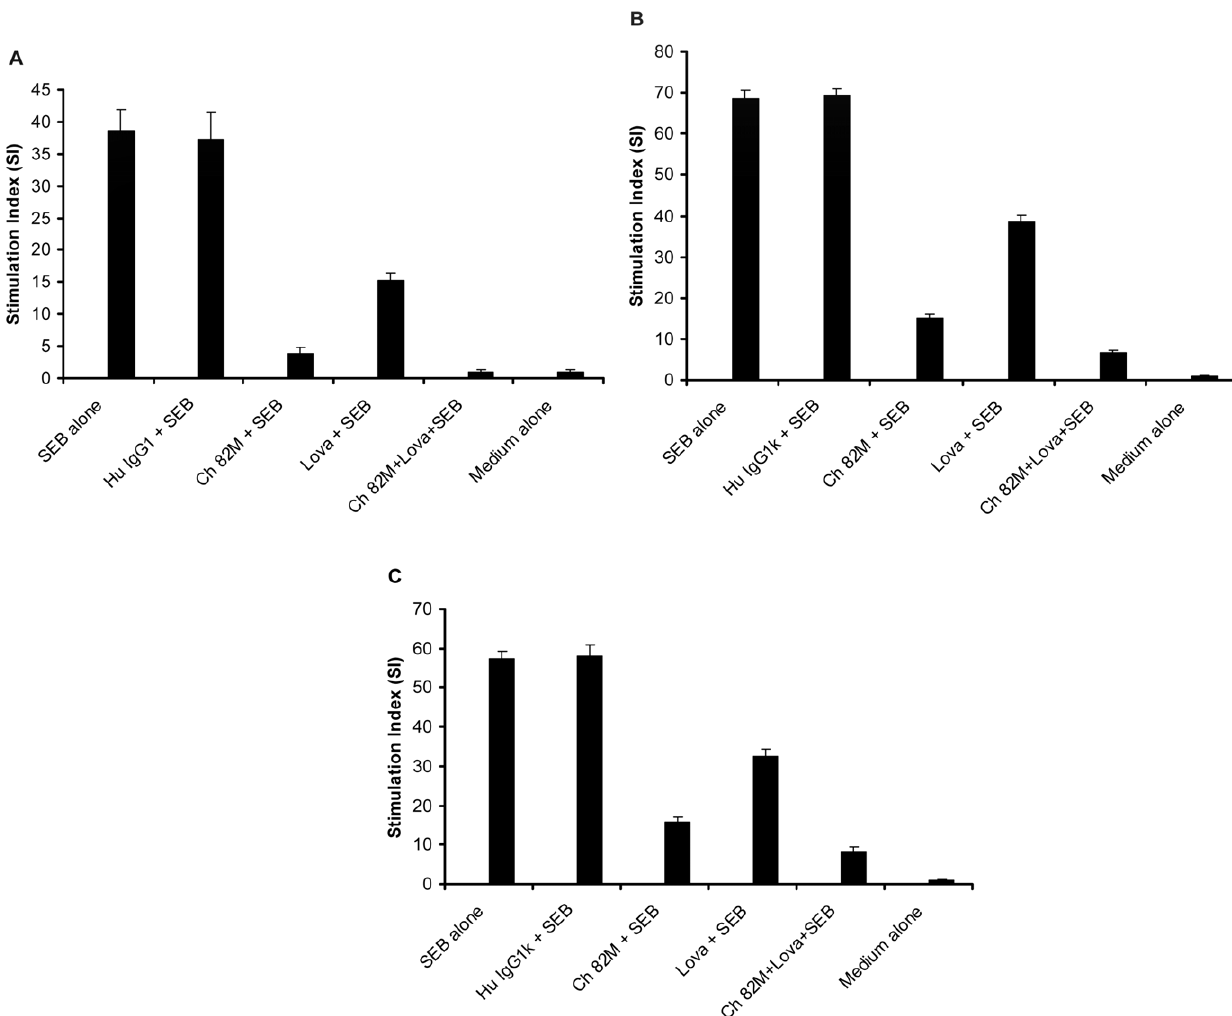
Figure 3. Synergistic neutralization /inhibition of SEB-mediated T-cell activation by a combination of anti-SEB antibody and lovastatin. ( A ) Anti-SEB Ch 82 M and lovastatin inhibit SEB action in BALB/c splenocytes. BALB/c splenocytes were cultured as outlined in